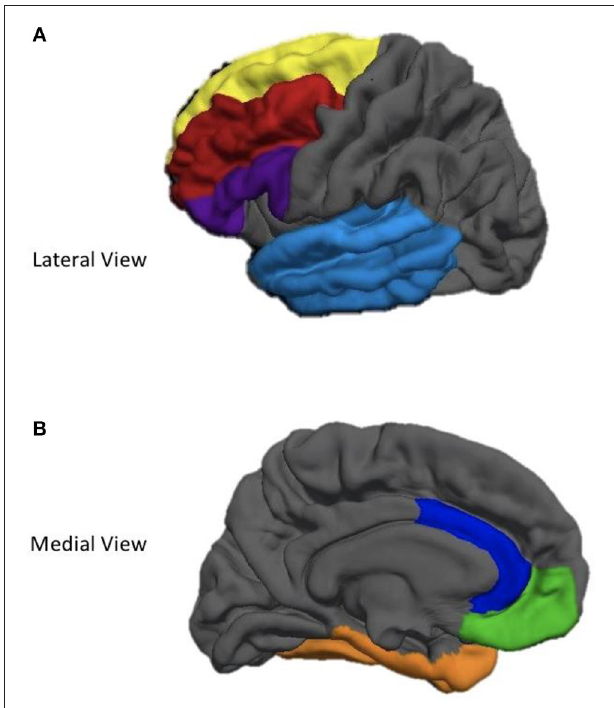
FIGURE 1 | Depiction of cortical regions of interest utilized in the current study. (A) Yellow, Superior Frontal gyrus; Red, Middle Frontal Gyrus; Purple, Inferior Frontal Gyrus; Light Blue, Lateral Temporal Lobe. (B) Blue, Anterior Cingulate Cortex; Green, Oribitofrontal Cortex; Orange, Medial Temporal